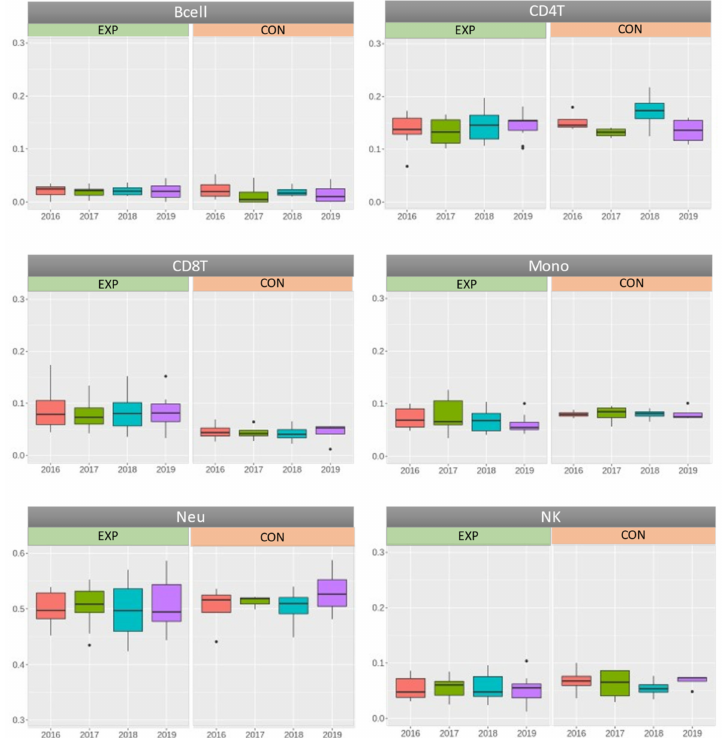
Figure A1. The comparison of proportions of individual blood cell types (Bcell: B lympho- cyte cells; CD4T: T h helper cells; CD8T: T c cytotoxic cells; Mono: monocytes; Neu: neutrophils; NK: natural killer cells) for individual years (2016–2019) in NP-exposed research workers (EXP) and controls